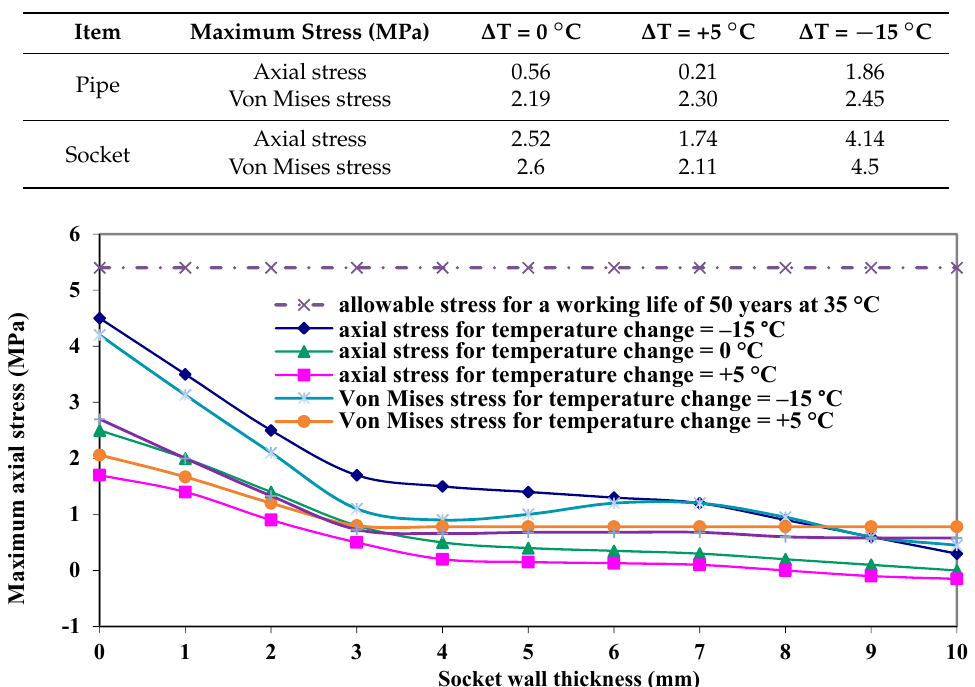
Figure 4. Maximum axial and Von Mises stress variations in the wall of buried socket joint (the simultaneous effect of soil load, internal pressure, vehicle wheel load and temperature variations).